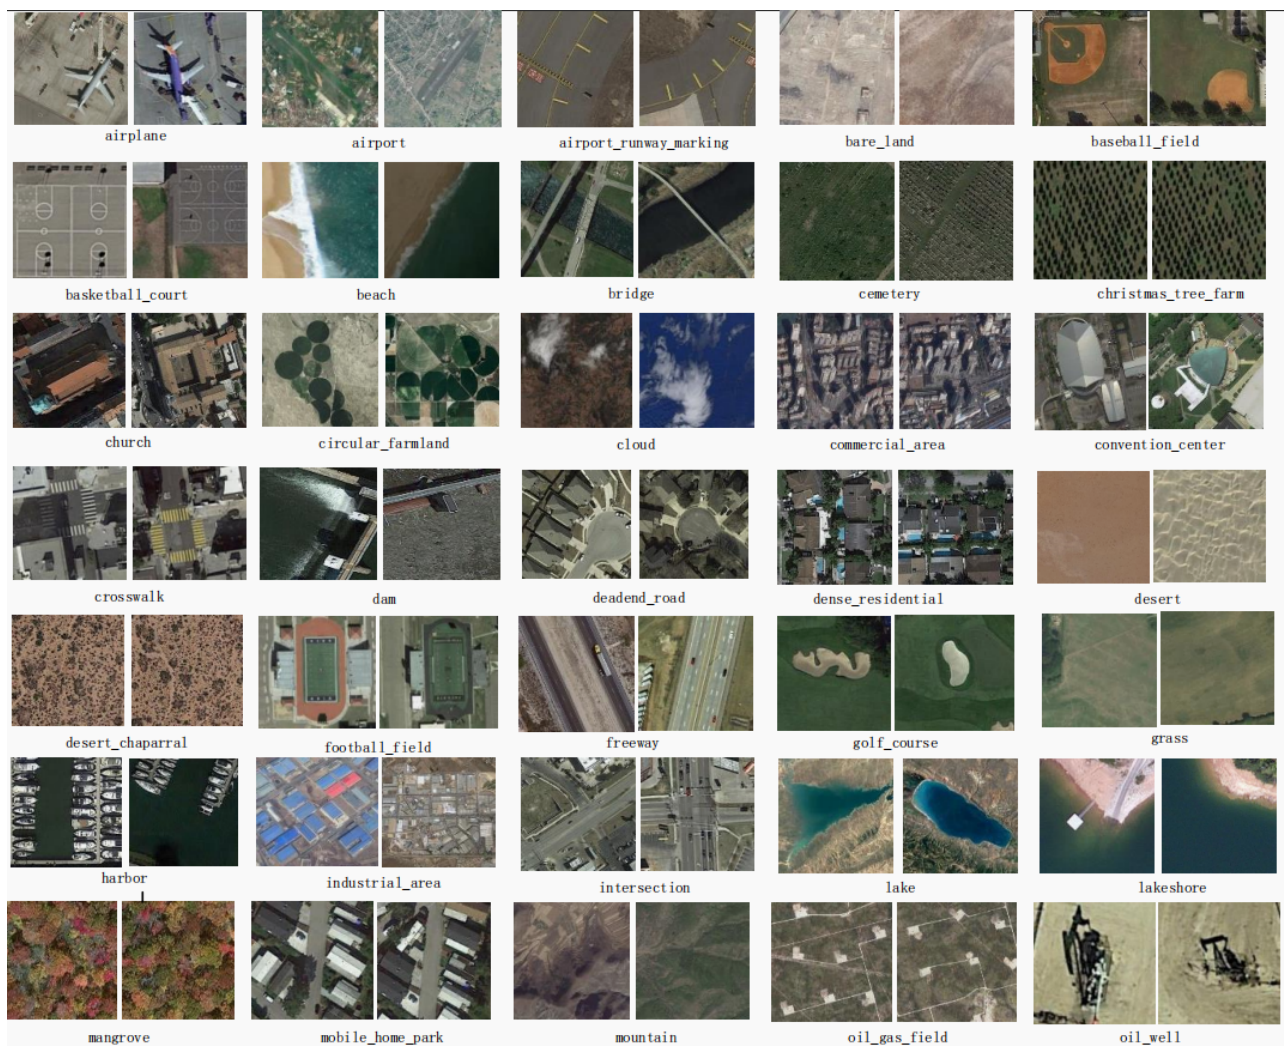
Figure 3. The examples of the remote sensing image scenes of the